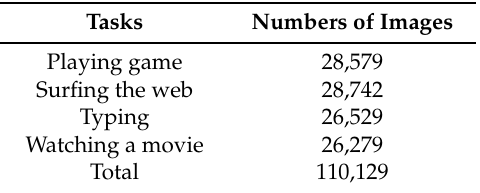
Table 2. The numbers of images during